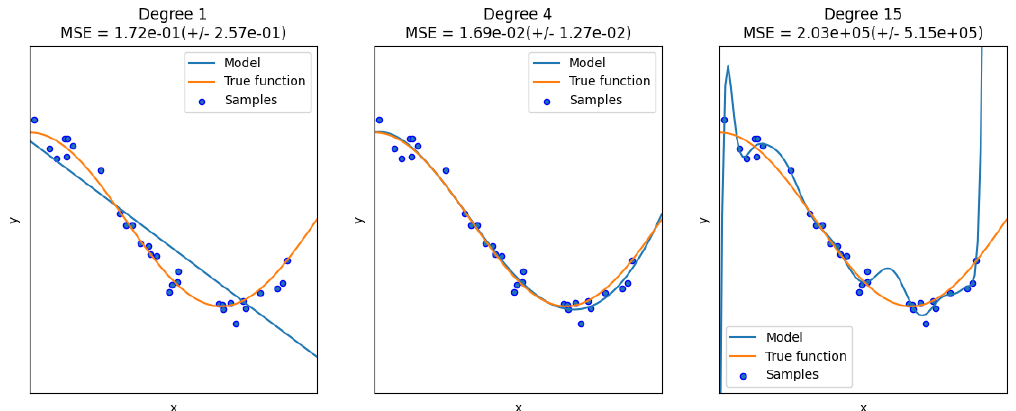
Figure 19. Under, good, and overfitting a polynomial regression model of various degrees. Overfitting Prevention